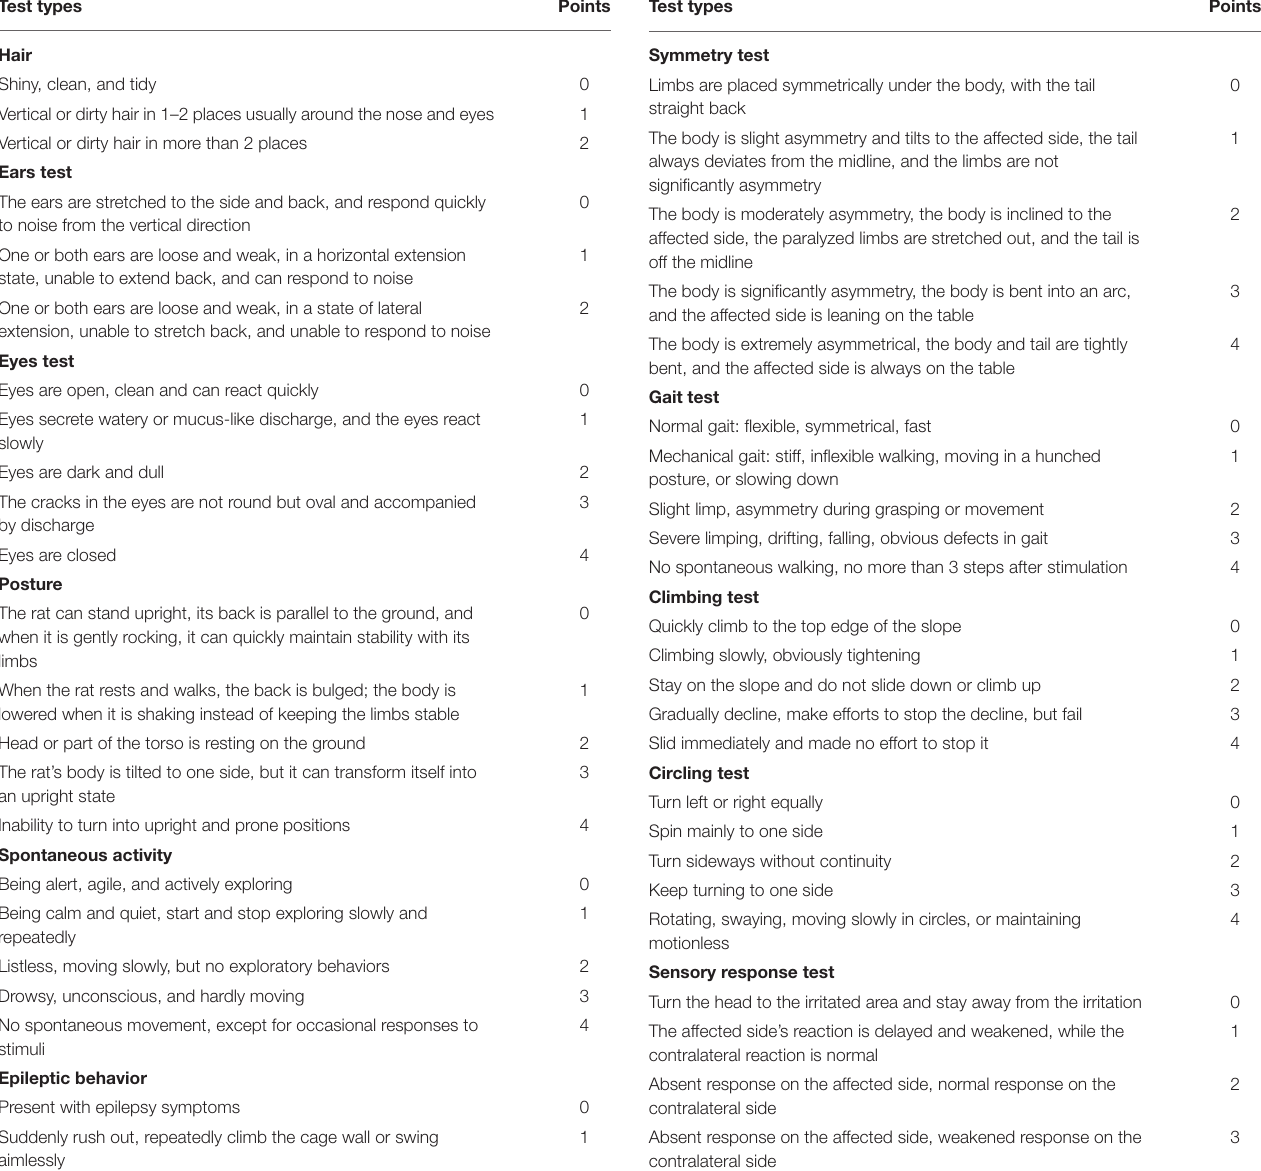
TABLE 3 | The scoring scheme of the focal deficits in symmetry, gait, climbing, circling, and sensory response. Test